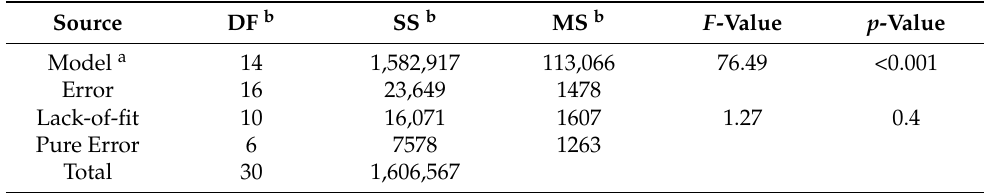
Table 3. ANOVA for the RSM model.